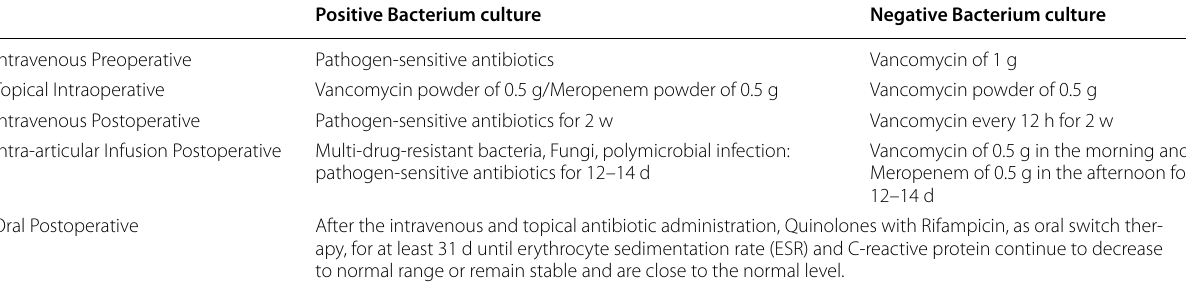
Table 2 Antibiotic treatment protocol